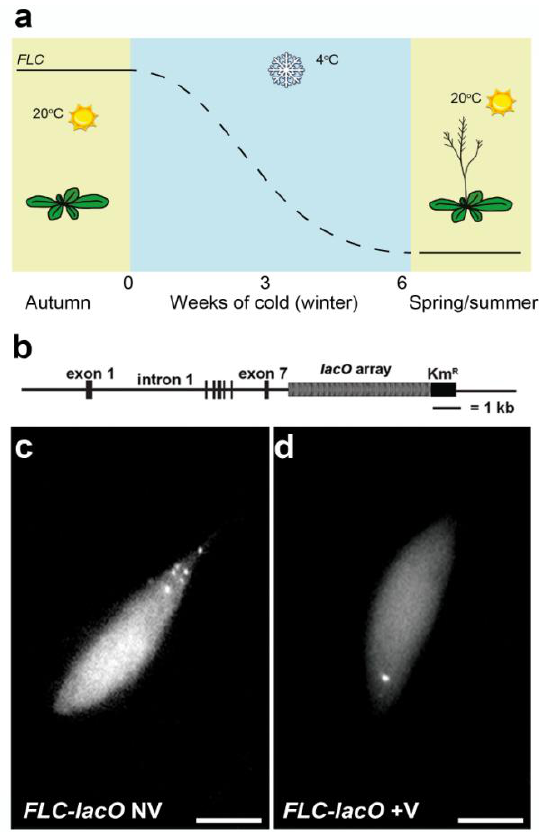
Figure 4. Vernalization in Arabidopsis involves Polycomb-mediated epigenetic silencing of FLOWERING LOCUS C (FLC) and physical clustering of FLC alleles. ( a ) Schematic representation of changes in FLC expression during vernalization; ( b ) FLC nuclear position was monitored in root nuclei using a FLC-lacO transgene. The lacO array was inserted downstream of the polyadenylation site of FLC ; ( c (cid:177) d ) Representative fluorescence images of Arabidopsis root cells in plants grown in warmth conditions (non-vernalized, NV) ( c ) and plants grown in cold for 2 weeks (vernalized, +V) ( d